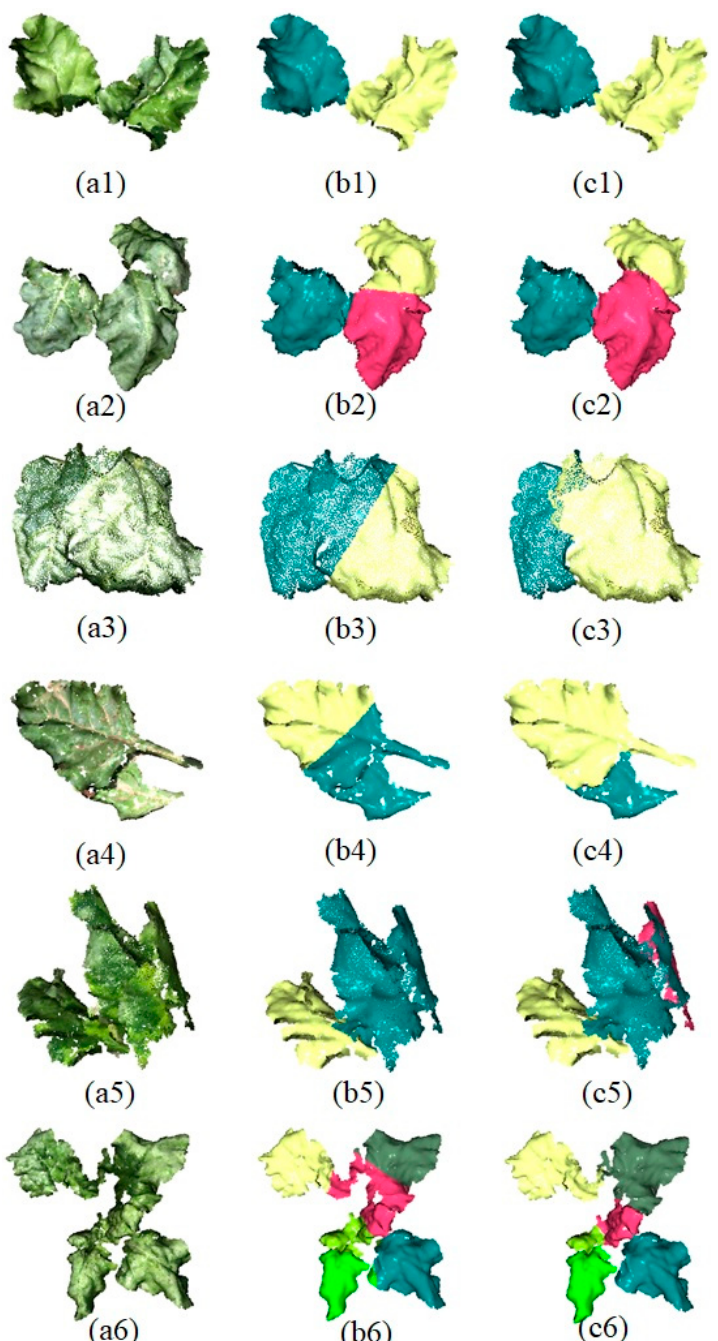
Figure 7. Visualization of leaf segmentation results using SBF and K-means clustering algorithm. ( a1 – a6 ) are the original leaf point clouds with different complex; ( b1 – b6 ) are the leaves separated with the K-means clustering algorithm; ( c1 – c6 ) are the leaves separated with the SBF. Table 3 evaluated the performance of SBF and K-means clustering algorithm in segmenting overlapping leaves. The t-test was used to compare the average of precision, recall, and f1-score of these two methods (Table 4). In addition, the results of Table 3 were expressed in boxplots (Figure 8). The SBF method produced a higher F1-Score, ranging from 0.83 to 0.97, a precision value ranging from 0.91 to 0.93, and a recall value ranging from 0.79 to 0.83, respectively, as shown in Table 3. The corresponding indicators for K-means were 0.75~0.79 for F1-Score, 0.87~0.88 for precision, 0.76~0.79 for recall. Compared with the K-means clustering algorithm, SBF has higher mean values and lower standard